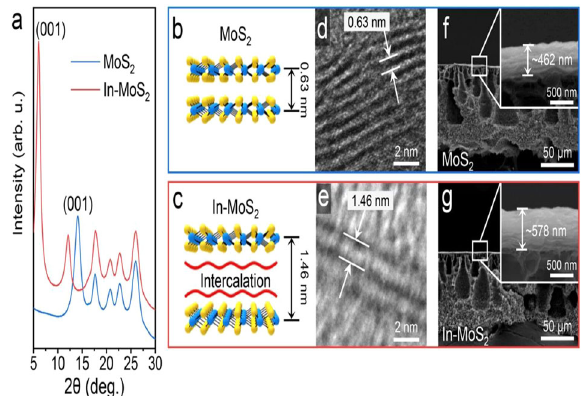
Fig. 4 MoS 2 fi lms deposited material characteristics. a Is the XRD pattern of the MoS 2 . b pristine MoS 2 without intercalation ( c ) intercalation was denoted as “ In-MoS 2 ” with interlayer spacing of 1.46 nm. d is TEM image ( e ) image of TEM ( f ) is the SEM cross- sectional images of the pristine MoS 2 fi lm that has an interlayer spacing of 0.63 nm, ( g ) SEM cross-sectional images of the intercalated MoS 2 fi lm with interlayer spacing of 1.46 nm. Repro- duced with permission from Environ. Sci. Technol. 54, 15